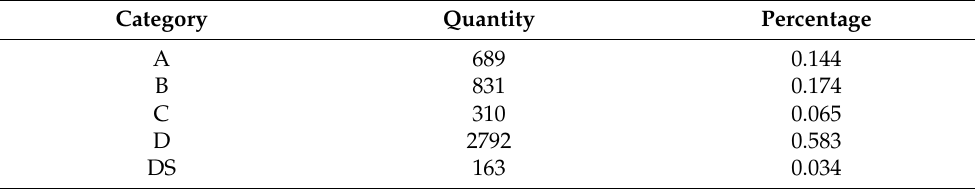
Table 1. Distribution of image categories of nonmetallic inclusions after cutting. Category Quantity Percentage A 689 0.144 B 831 0.174 C 310 0.065 D 2792 0.583 DS 163